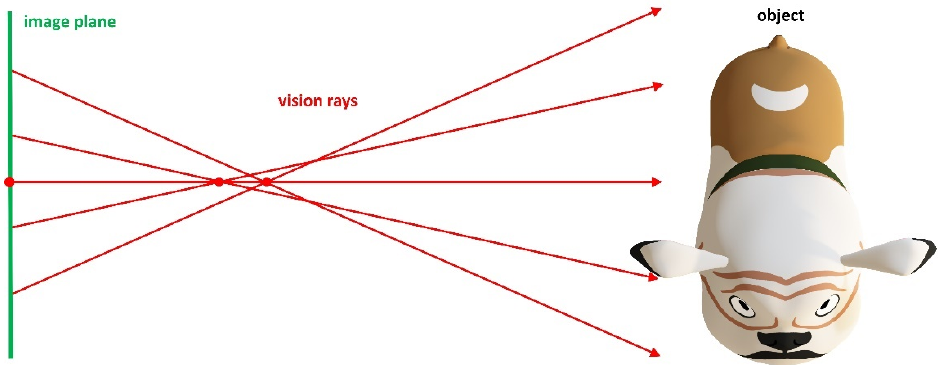
Figure 4. Variable principal distance. Rays corresponding to pixels with common distance to principal point intersect.